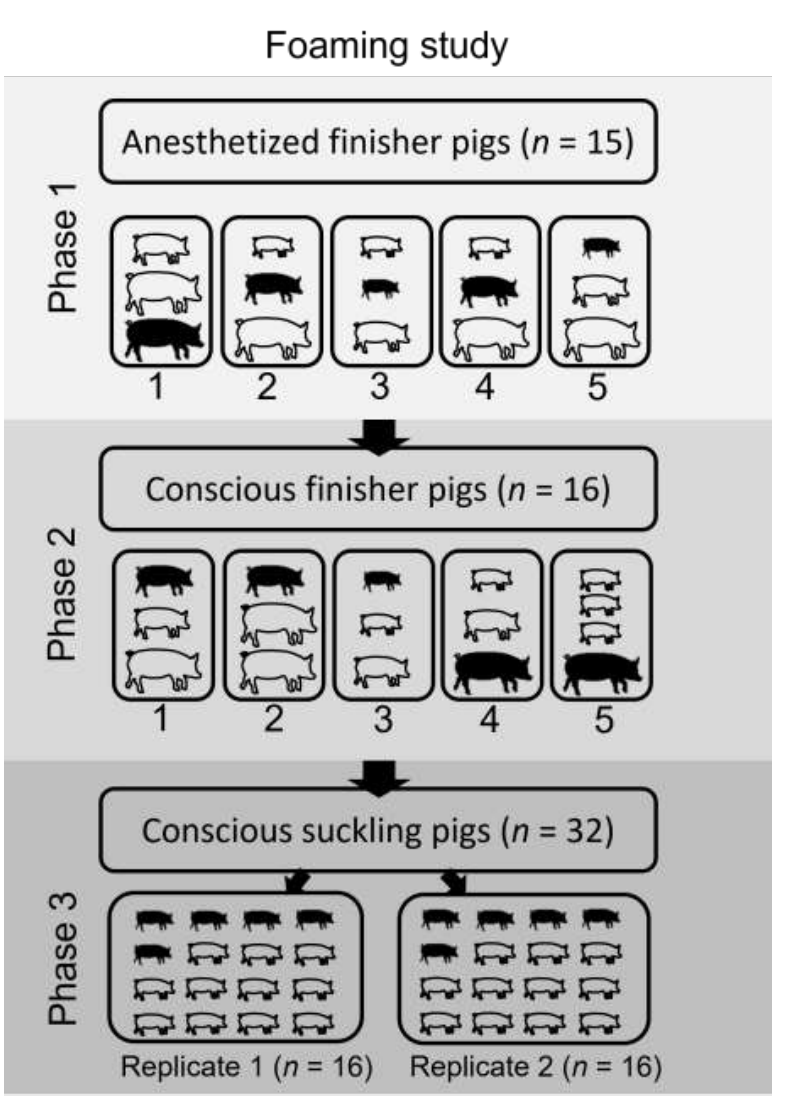
Figure 2. Chronological study phase progression for anesthetized finisher pigs ( n = 15), conscious finisher pigs ( n = 16) and conscious suckling pigs ( n = 32). The number of replicates for each phase is broken down and demarked in black outline. The number of pigs and pig sizes within each finisher pig replicate correspond to pigs of each weight category (light = 21 to 23 kg; medium = 32 to 36 kg; heavy = 34 to 55 kg). The number of suckling pigs (mean weight = 3.2 ± 0.8 kg) only indicate the number of pigs used per replicate and size does not correspond to any above-mentioned finisher weight category. Pigs with an implanted activity logger are represented as outlined in black for each phase and replicate.